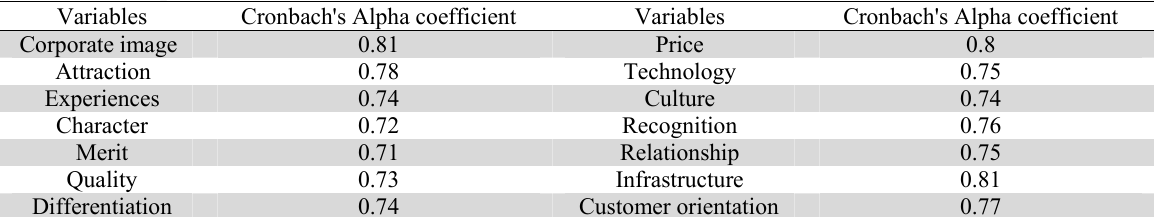
Cronbach's Alpha